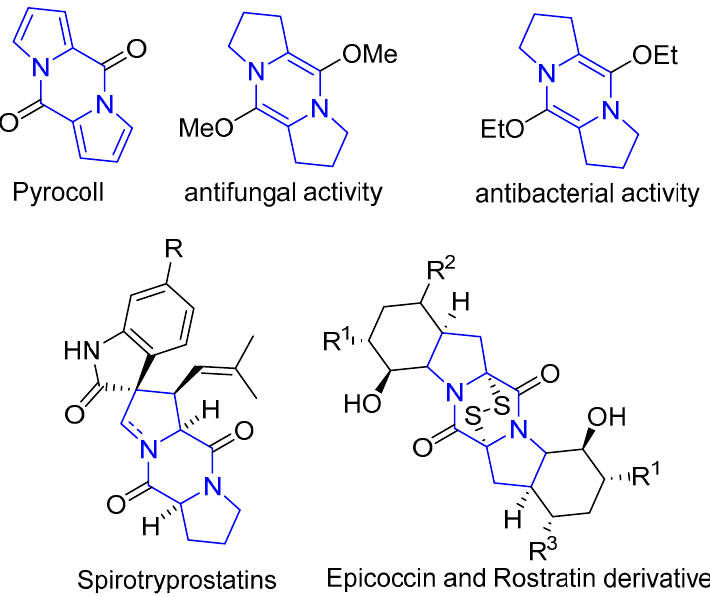
Figure 1. Biologically active dipyrrolo[1,2- a :1 ′ ,2 ′ - d ]pyrazines.